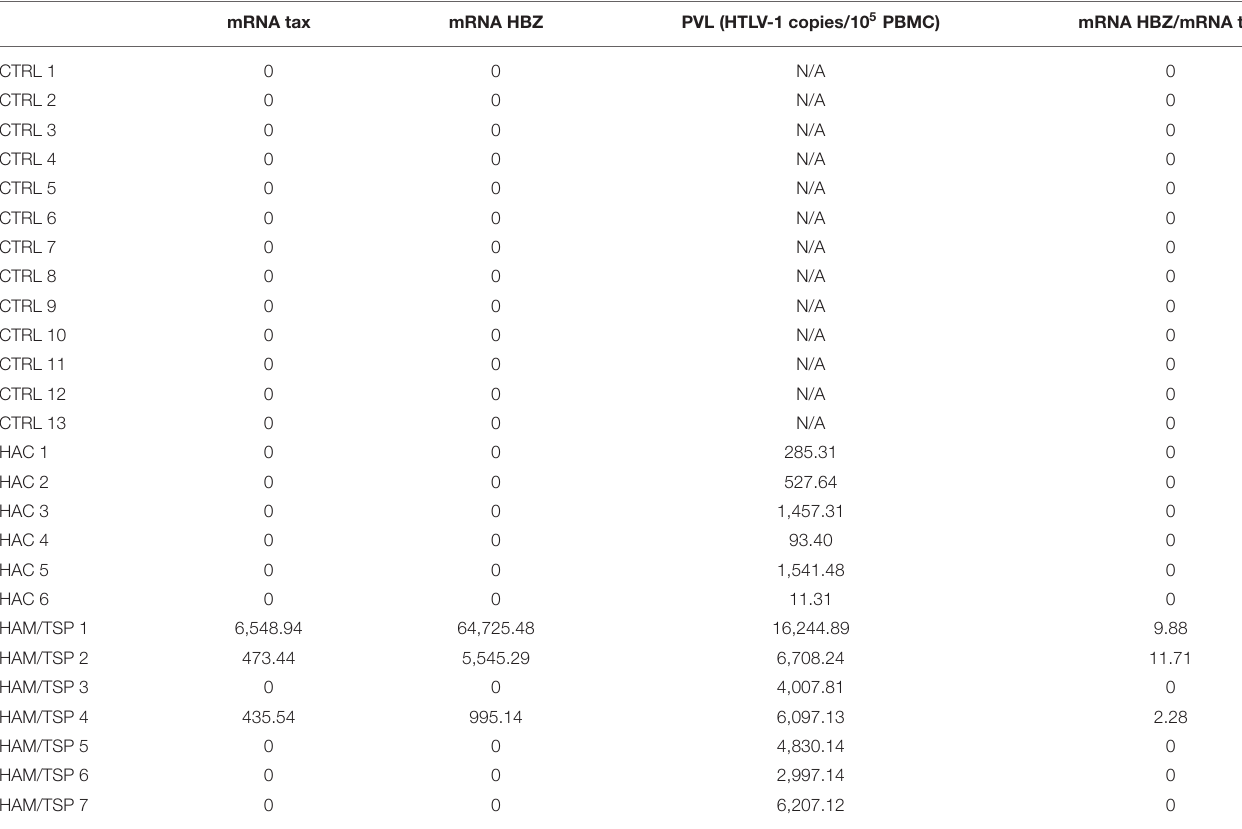
TABLE 1 | Comparison between tax and HBZ messenger RNA (mRNA) expression in small extracellular vesicles (sEVs) and the proviral load (PVL) of human T-lymphotropic virus 1 (HTLV-1)-infected individuals. mRNA